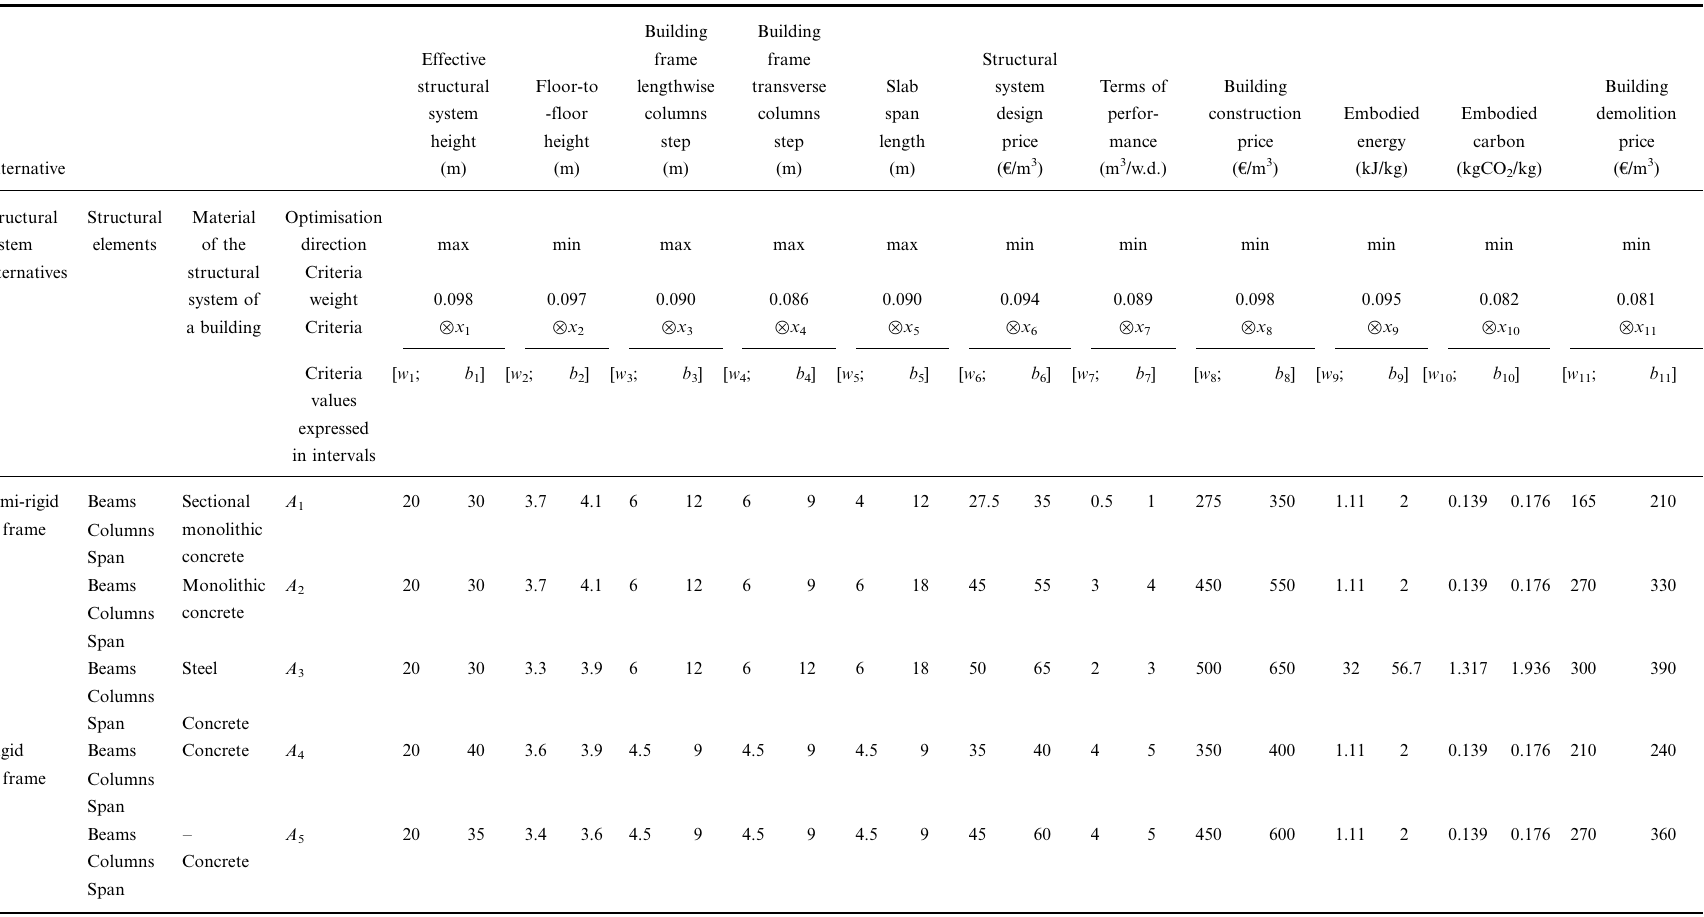
Table 3. Initial decision-making matrix with criteria values expressed in intervals